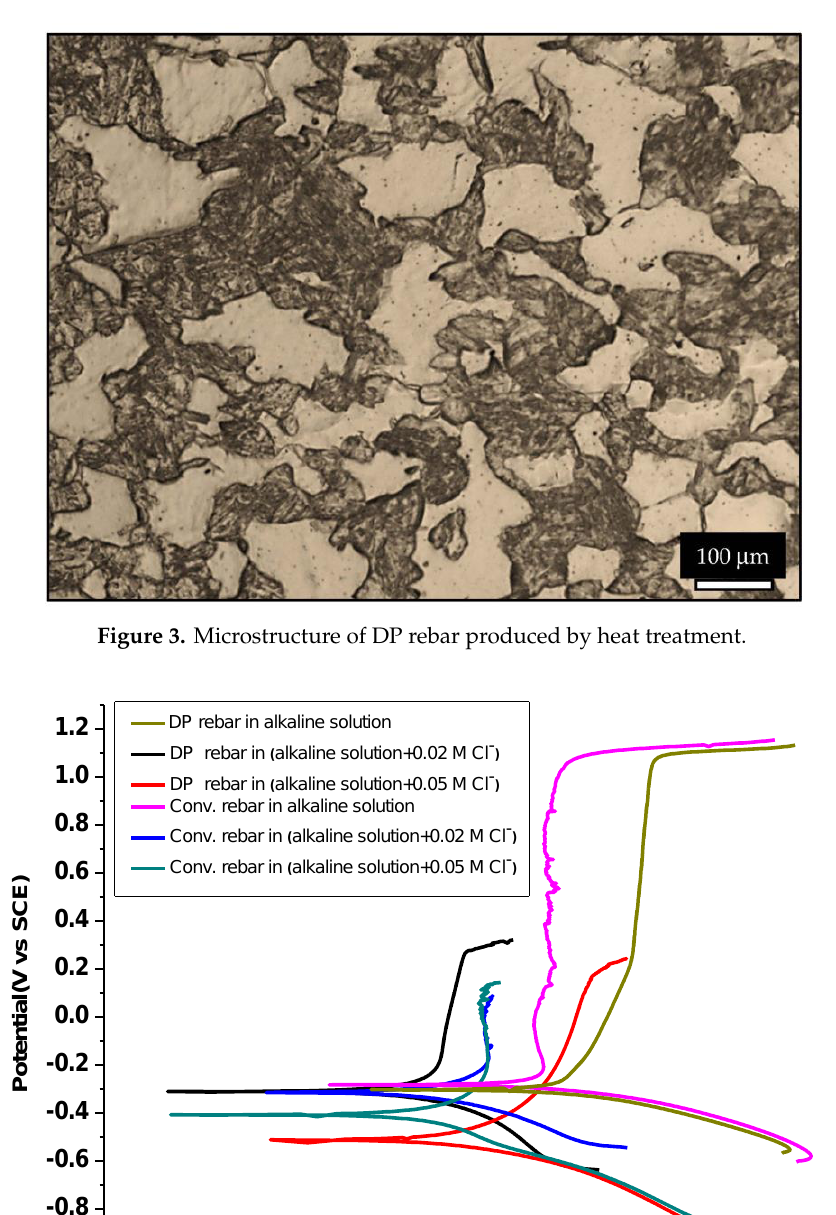
Figure 3. Microstructure of DP rebar produced by heat treatment.